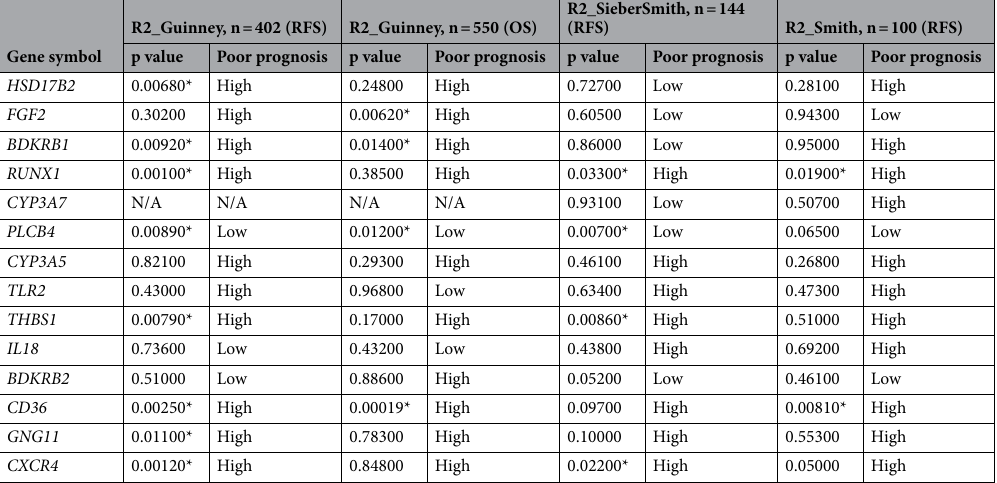
Table 3. Survival analysis of down-regulated key genes. * p <